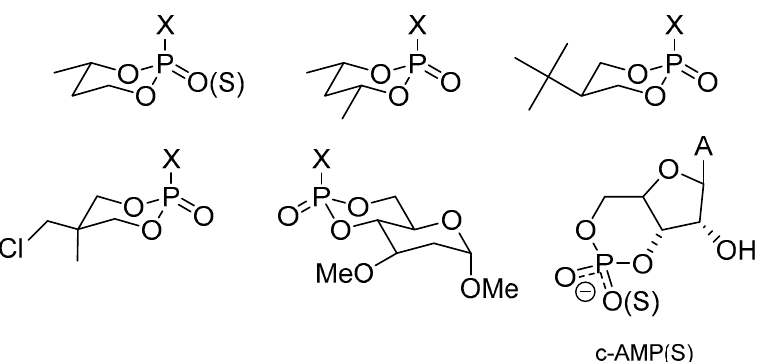
Figure 2. Structures of 1,3,2-dioxaphosphorinanes most often used in studies of displacement reactions at phosphorus.